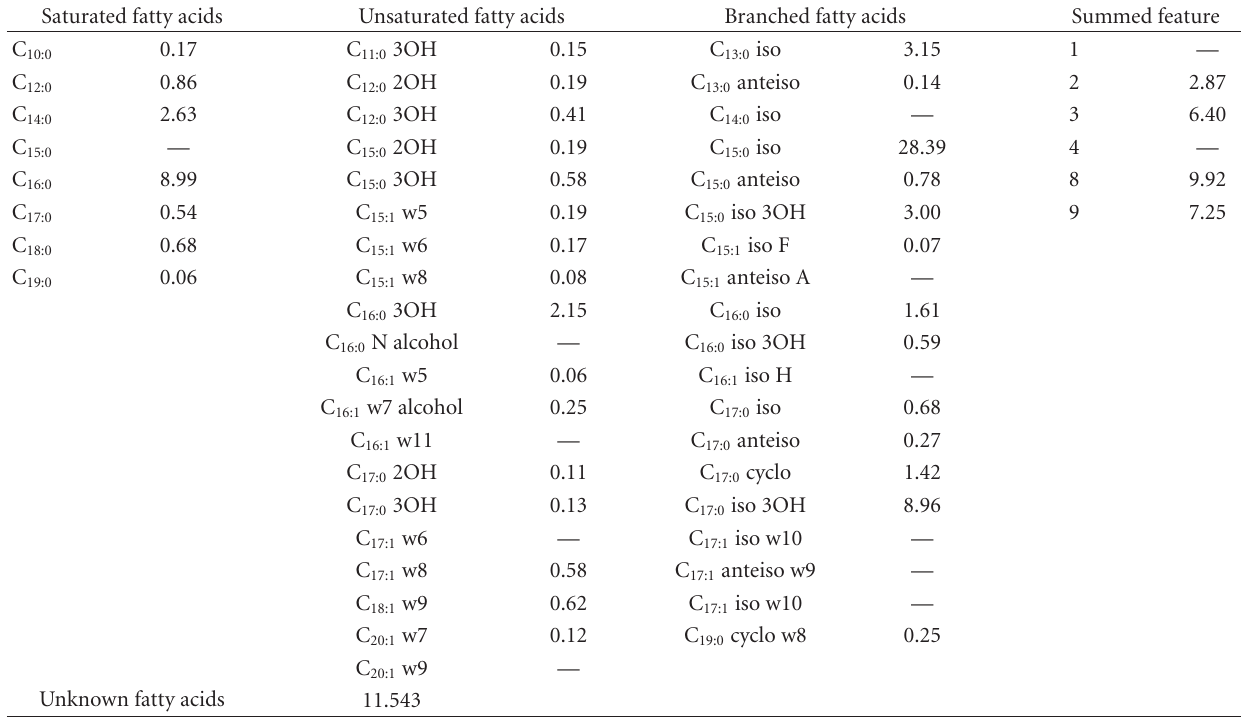
Table 3: Fatty acid composition of Sporosarcina aquimarina